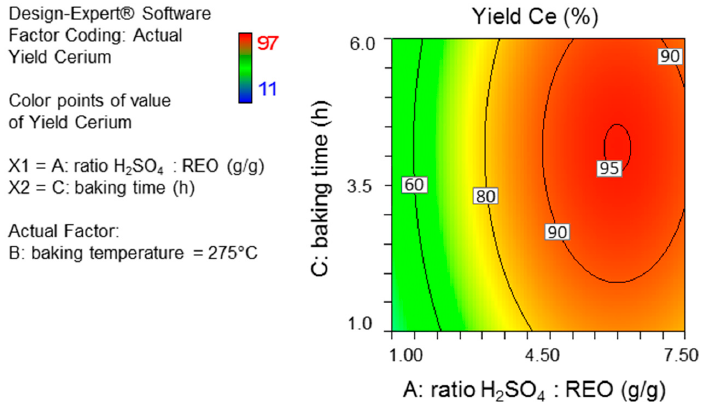
Figure 11. Contour diagram for the response “Yield Ce” for the combined effects of ratio of H 2 SO 4 to REO and baking time. The baking temperature is set to 275 °C.